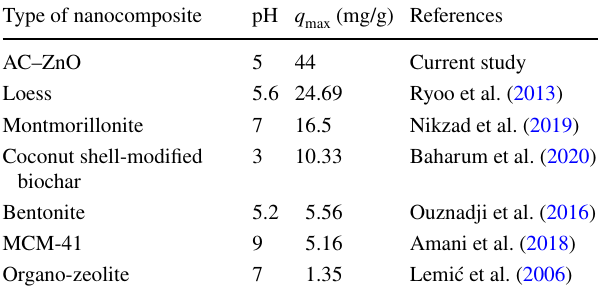
Table 6 Comparison of maximum absorption capacity ( q ferent nanocomposites for DZN